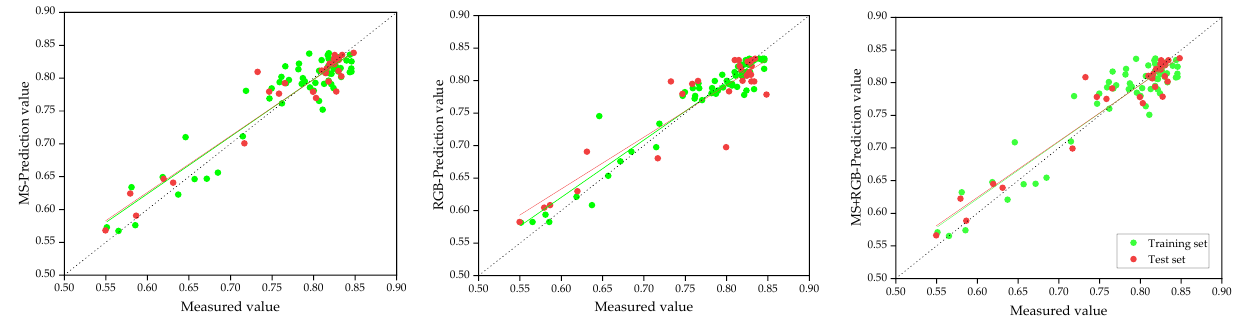
Figure 3. Calibration and validation results of the highest accuracy model in MS, RGB, RGB+MS data after hyperparameter optimization.